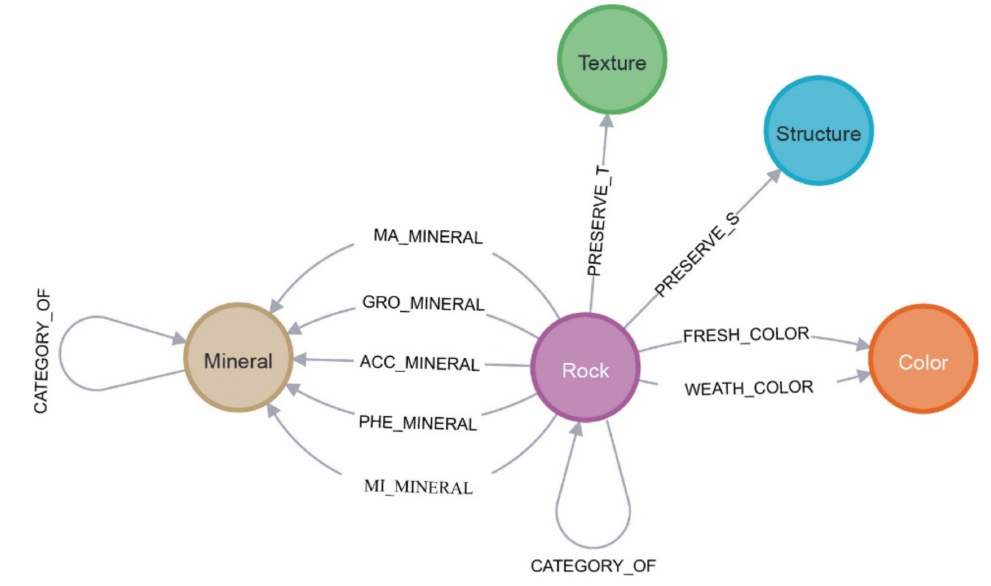
Figure 3. Meta-graph for named entities and relations of the domain-specific KG of